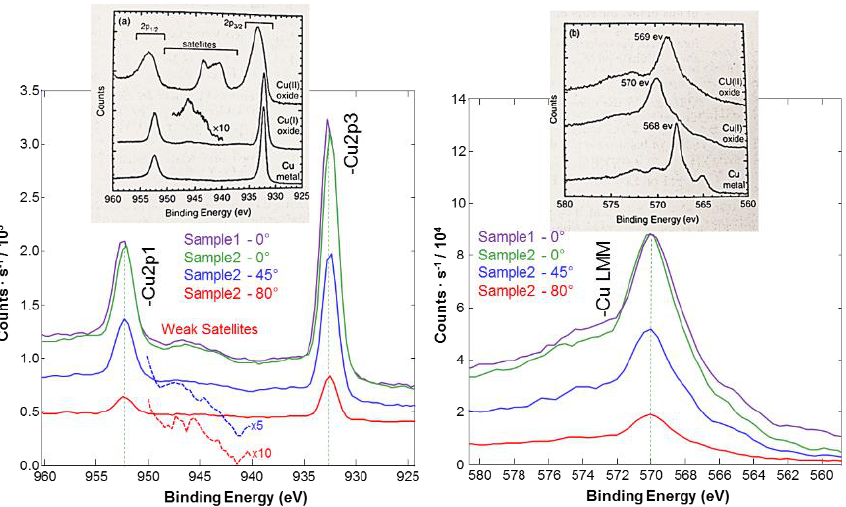
Figure 3. High resolution XPS spectrums of Copper photoelectron peaks compared on two different samples. The take-off angle on one of the samples verified the consistency of the measurement at different